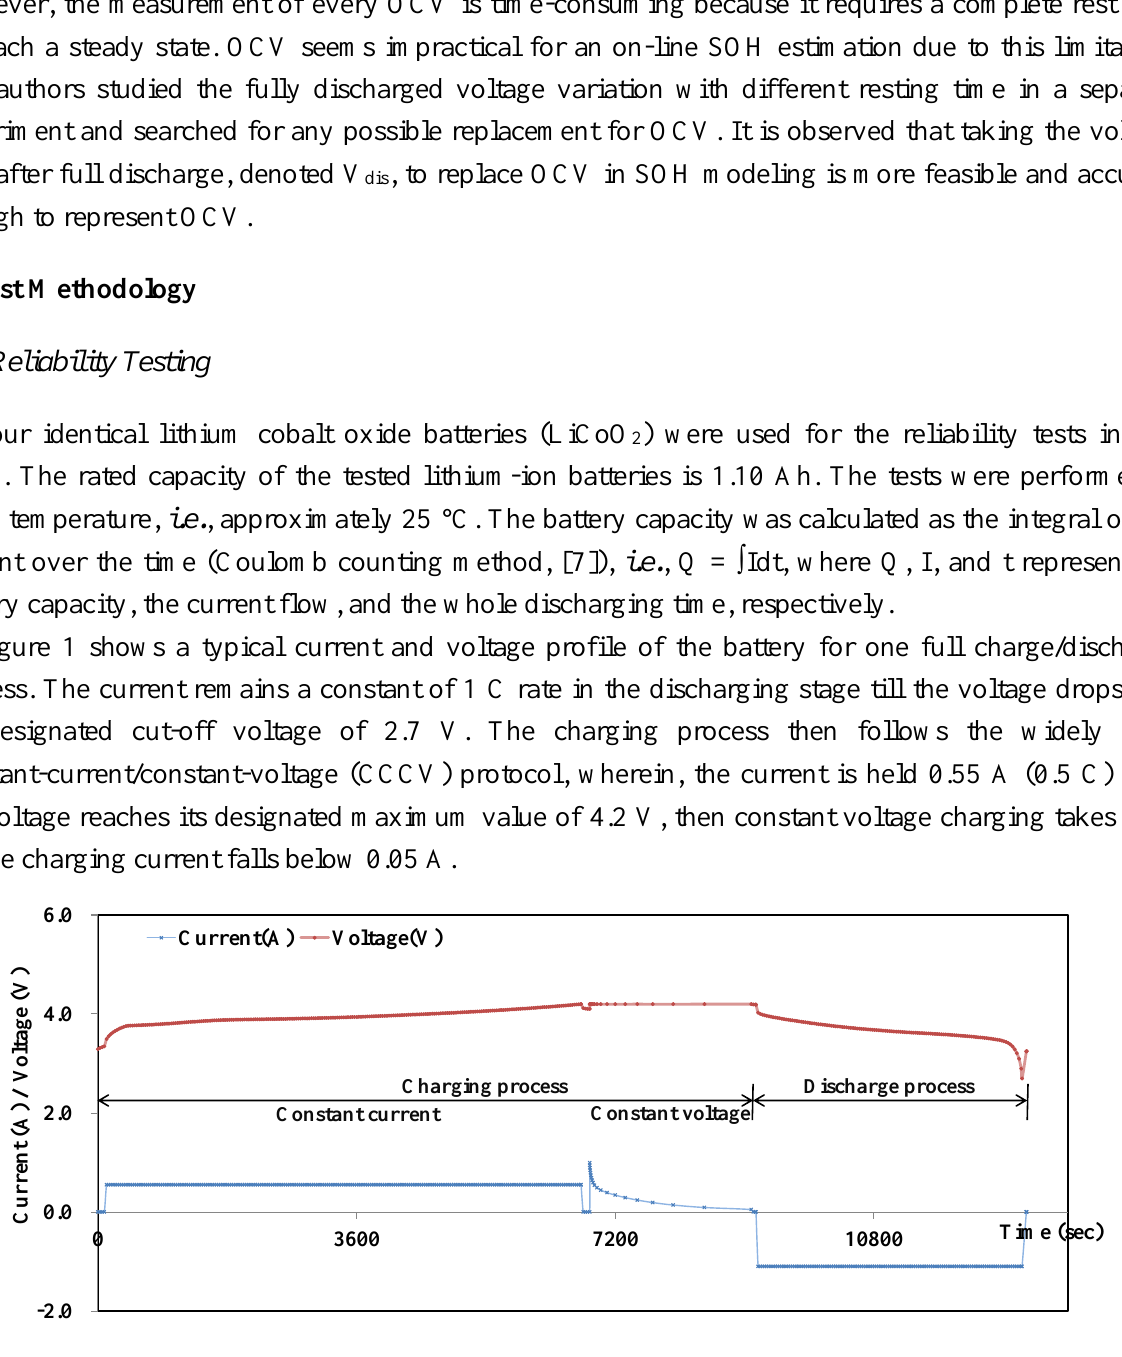
Figure 1. Charge-Discharge current and voltage